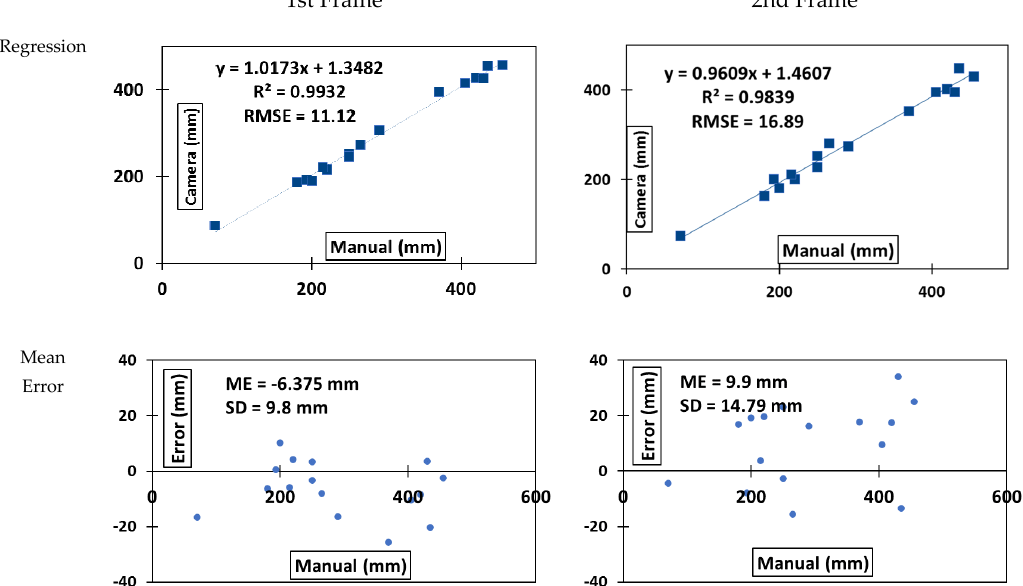
Figure 12. Comparison of the image frames when the rover was stationary. The y-axis is the camera measurements, while the x-axis is the manual measurements. the first and second frames were taken consecutively to compare the depth estimation.